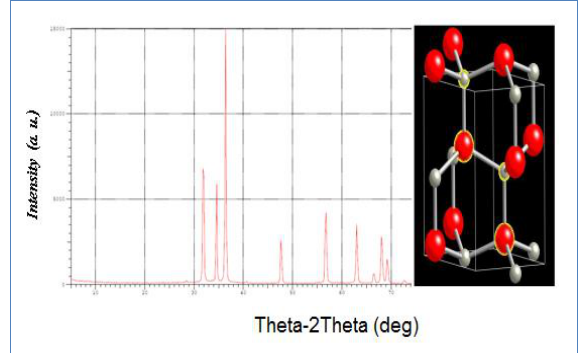
Figure, 3: XRD patterns of ZnO nanopartical.